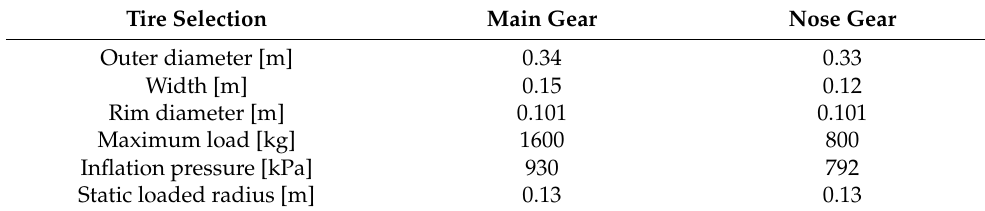
Table 9. Tire selection specifications.